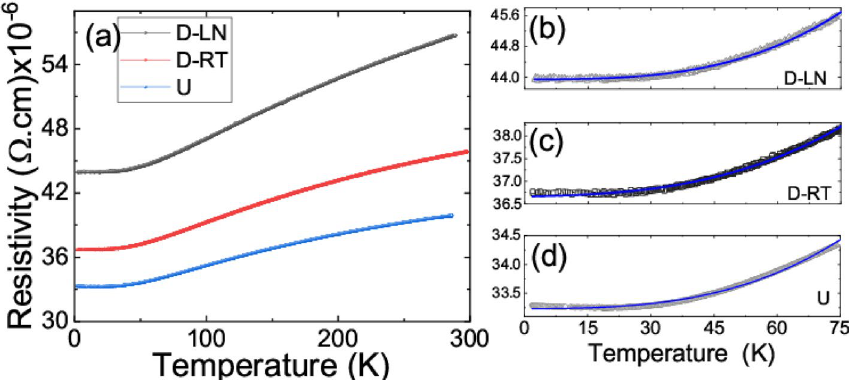
Figure 8. ( a ) Temperature dependence of the zero field resistivity of all samples. ( b ) Temperature dependence of the zero field resistivity for the temperature range of 2–75 K. Solid lines are fit to the power